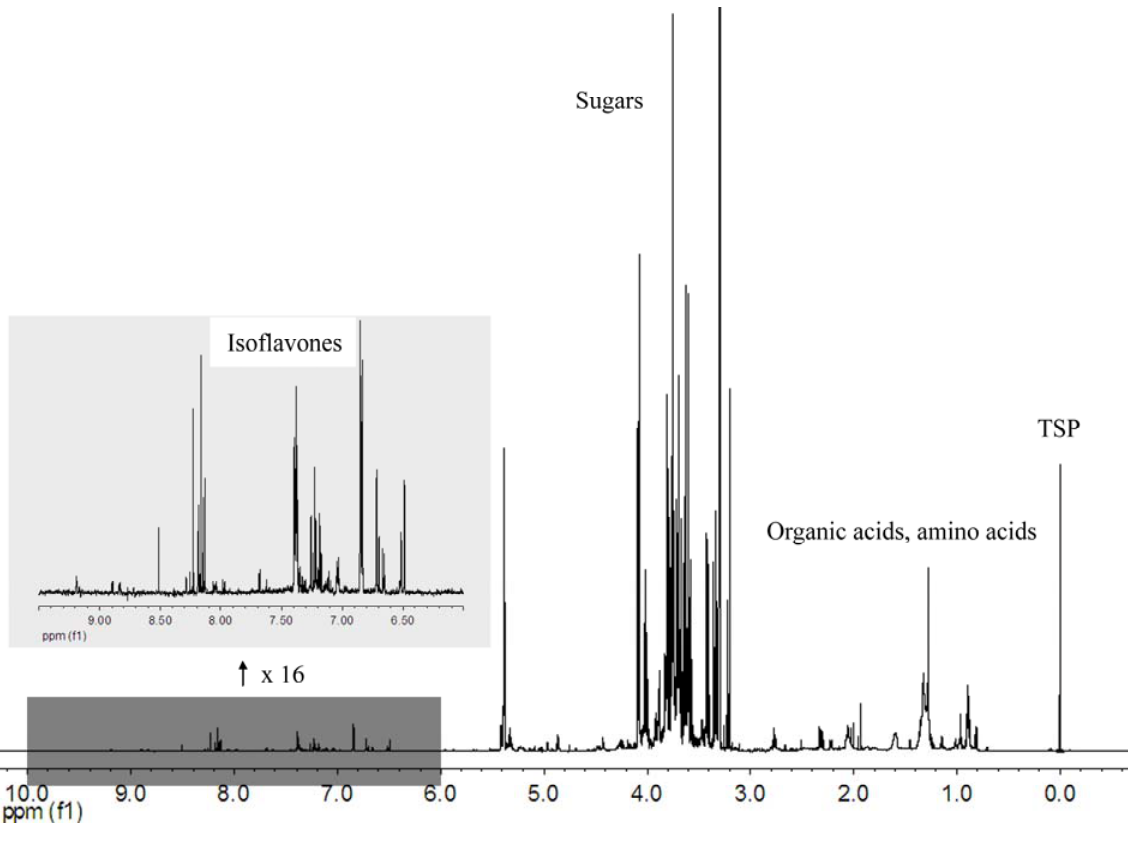
Figure 2. 1H NMR spectrum of a soybean methanolic extract, with insert (x16) showing the aromatic region, mainly constituted of isoflavones